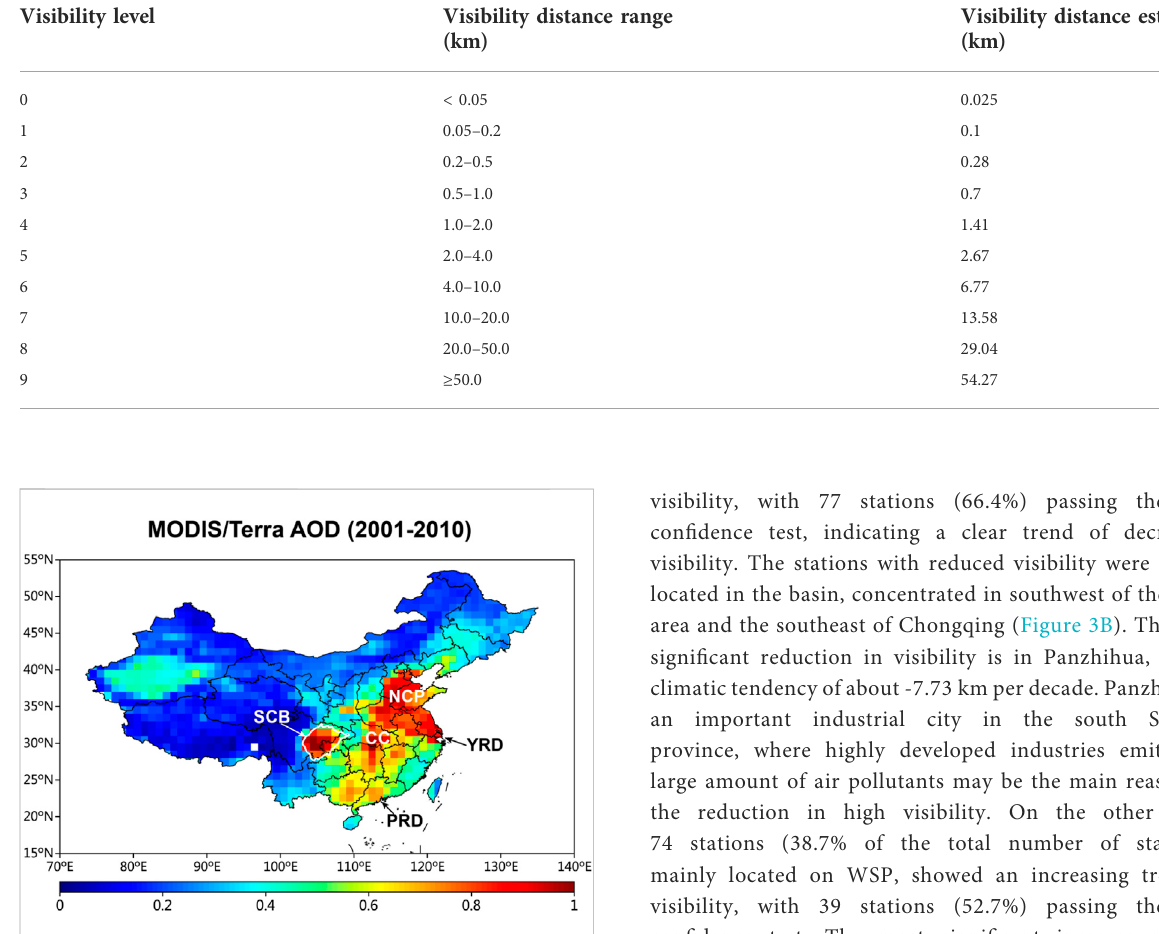
FIGURE 2 Spatial distribution of the AOD over China, aggregated over the years 2001 – 2010. Regions with relatively high AOD are marked, i.e., the SCB, the North China Plain (NCP), the Yangtze River Delta (YRD), the Central China (CC), and the Pearl River Delta